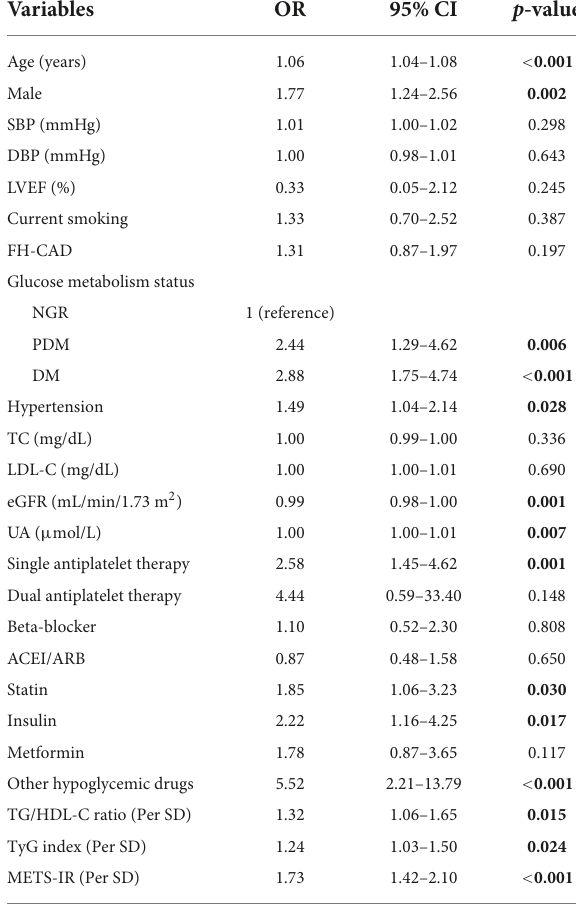
TABLE 3 Univariate logistic regression analyses for the presence of CAD.